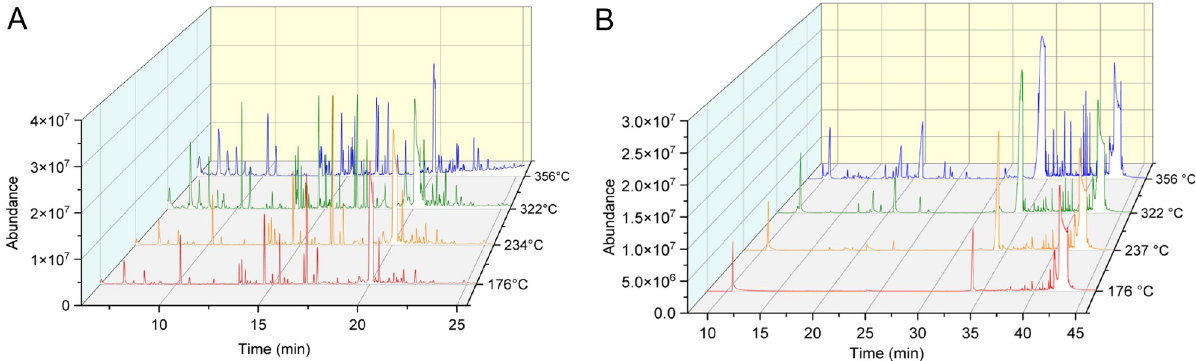
Fig 3. Total ion chromatographs (TIC) of VEA vaping emissions collected at 176, 234, 322, and 356˚C. TIC obtained from (A) a polar Rtx-VMS fused silica separation column and (B) a non-polar J&W Scientific DB-5MS separation column.